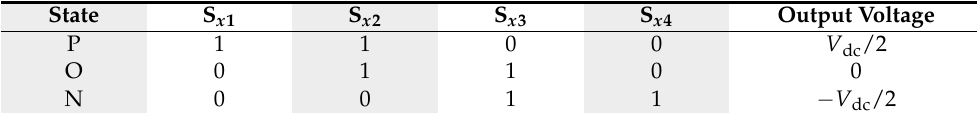
Table 1. Output voltage corresponding to each switching state.